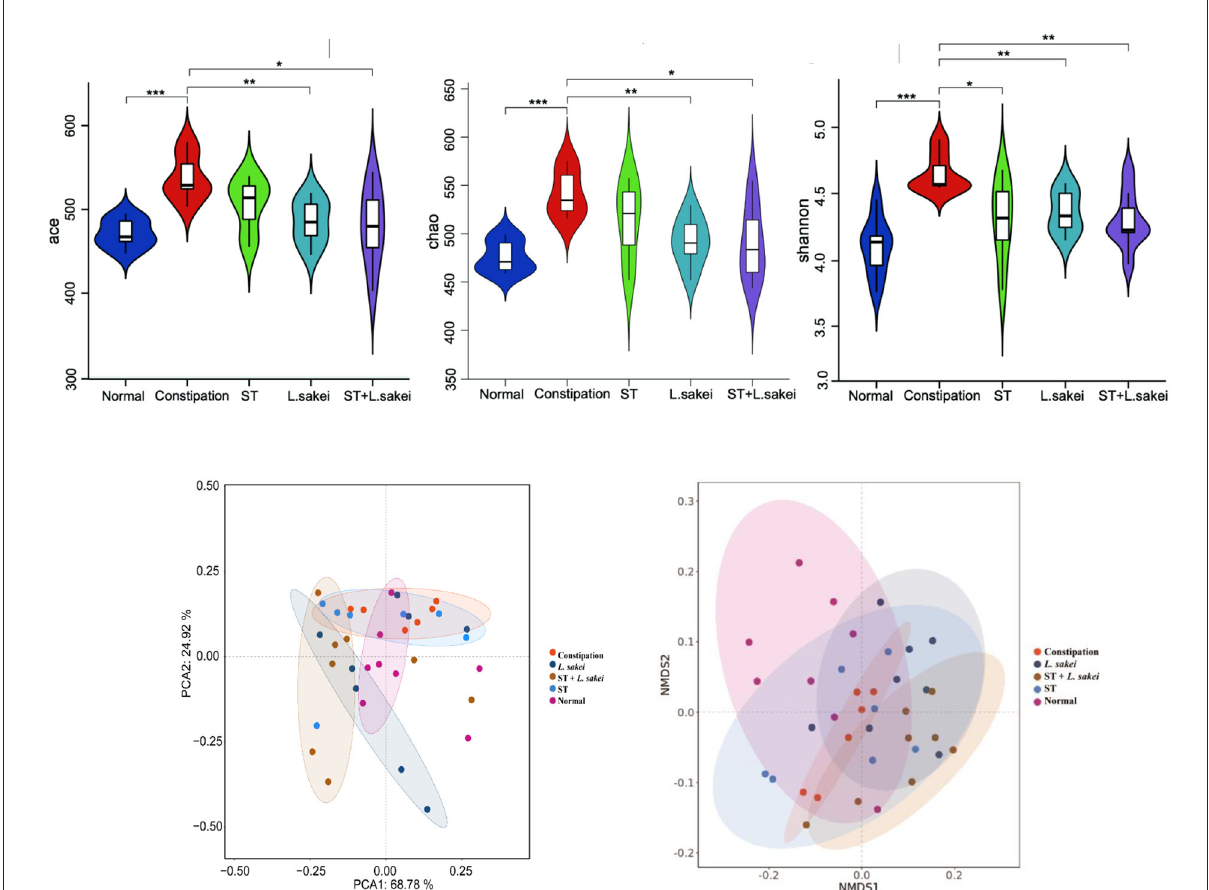
FIGURE6 The effect of ST or L. sakei alone or combined on the alpha diversity analysis and beta diversity analysis in mice microbiota. (A) Ace index; (B) Chao index; (C) Shannon index; (D) PCA score plot at the phylum level; (E) NMDS plot at the genus level. Data represent the mean ± SD ( n = 6–8). Wilcoxon signed-rank test of non-parameter statistics was used for constipation group vs. normal group, *** p < 0.001. Wilcoxon signed-rank test of non-parameter statistics was used for ST, L. sakei , and ST + L. sakei groups, vs. constipation group * p < 0.05, ** p <